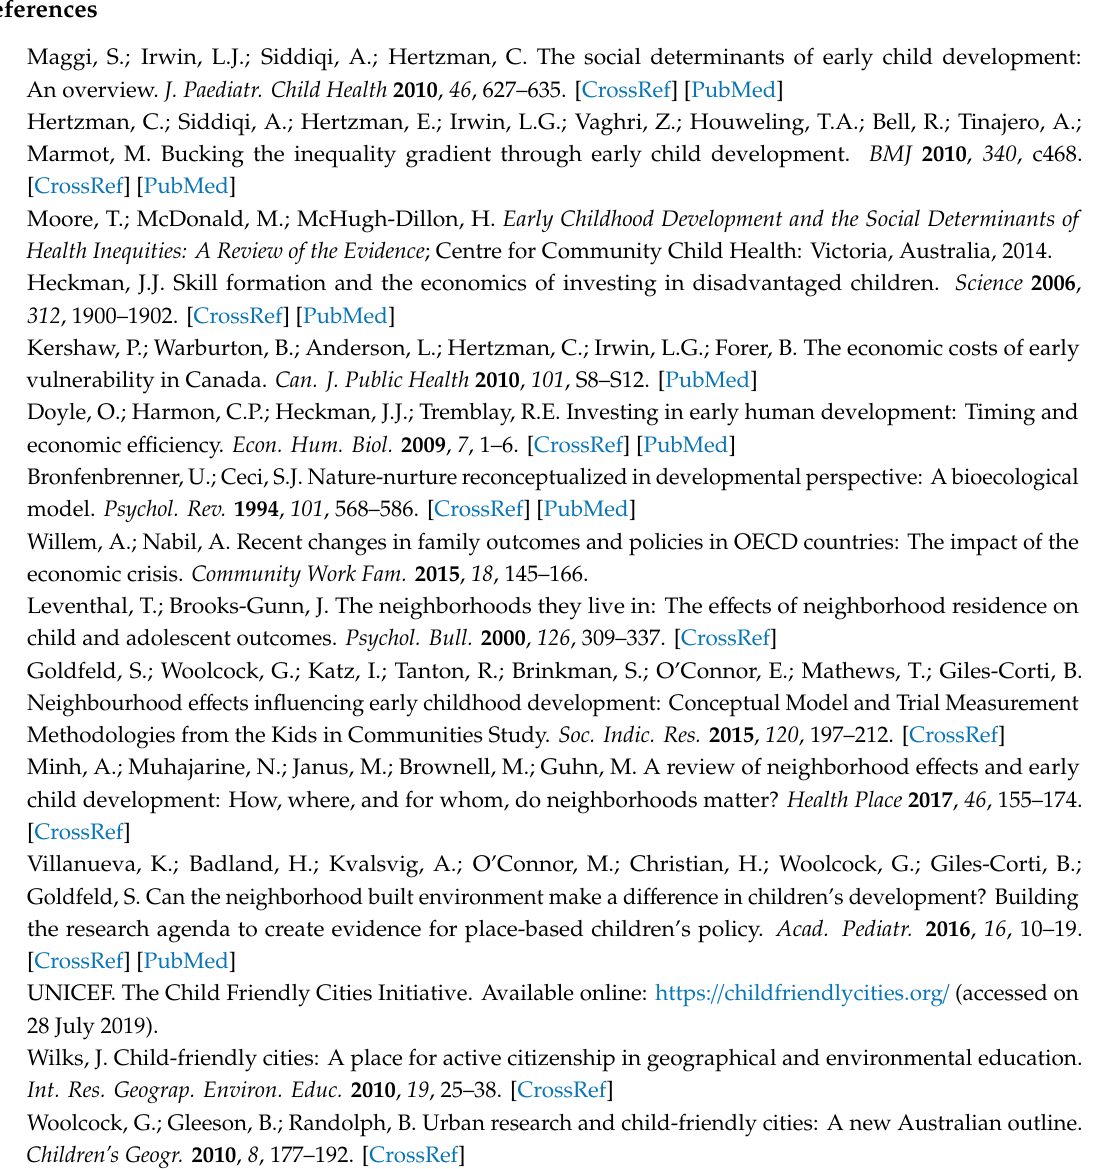
Table S1: By-domain Proportions of developmentally vulnerable children among subgroups in Montreal (MTL) and Melbourne